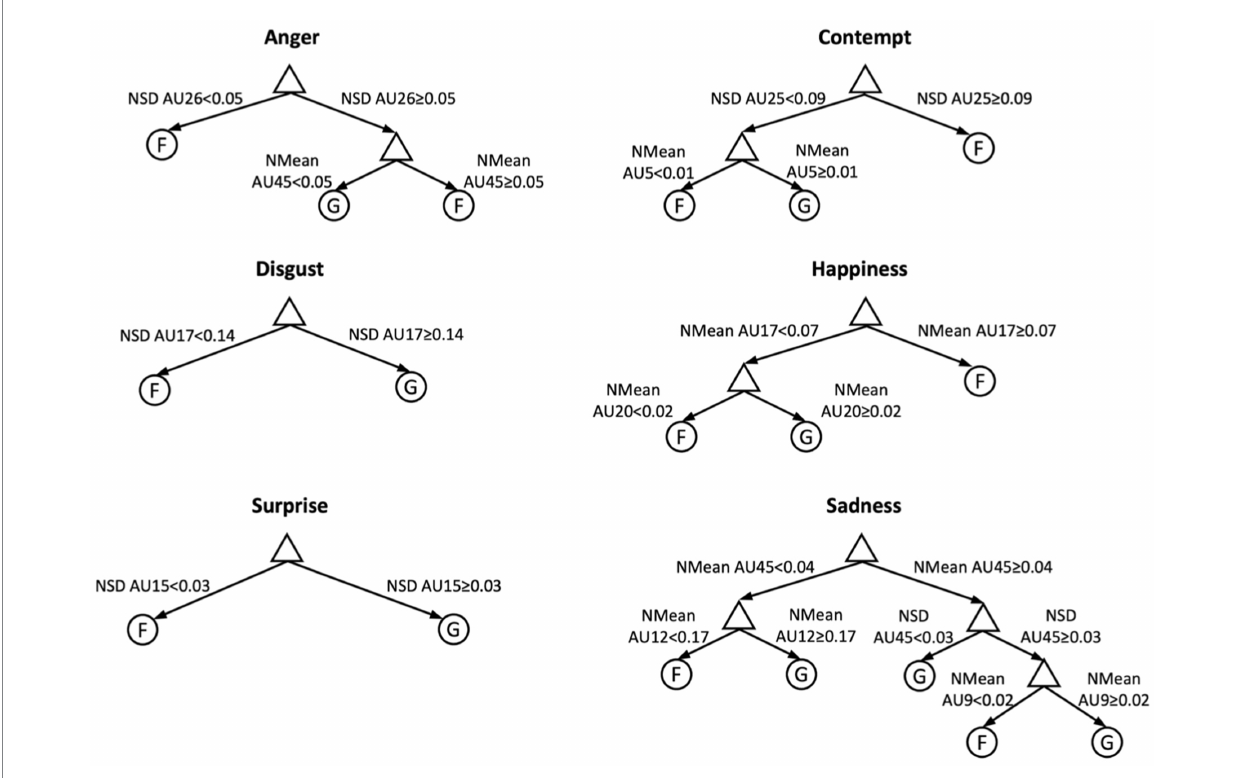
FIGURE 1 Best Tree models and normalized features (Nmean, NSD). Graphs report tree decision paths and feature thresholds to predict fake (F) and genuine (G) expressions. Image is modified from Cardaioli et al.